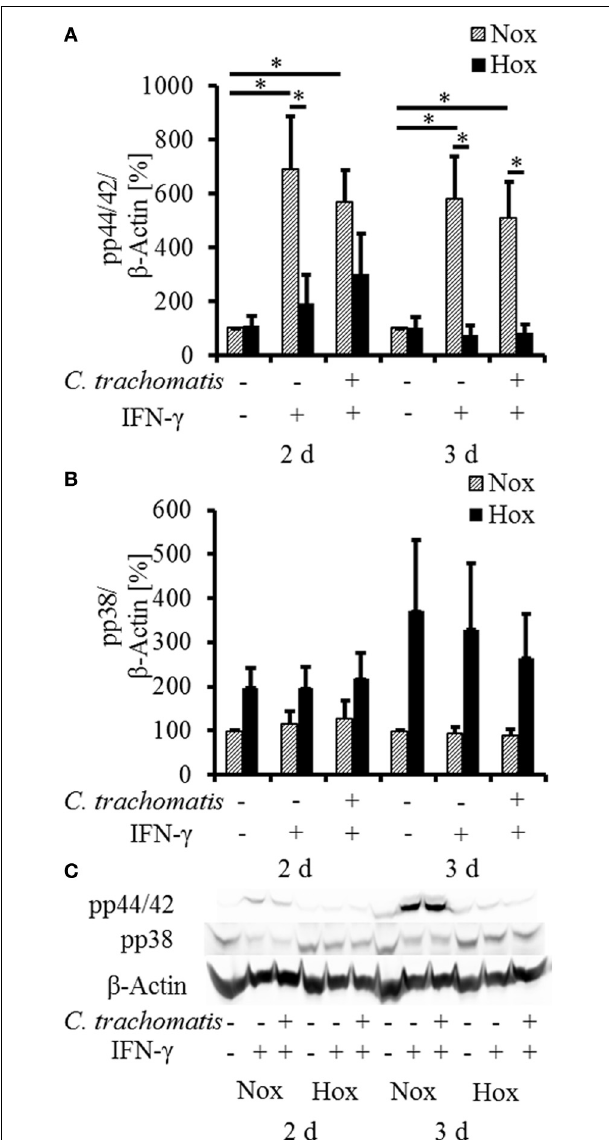
FIGURE 3 | Western blot analysis of MAP-kinase phosphorylation in IFN- γ treated C. trachomatis infected cells under normoxic and hypoxic conditions. Western blot and densitometric analysis of the phosphorylation of the MAP-kinases p44/42 (A) and p38 (B) in IFN- γ treated cells after 2 and 3 d cultivation under normoxic (Nox) and hypoxic (Hox) conditions ( n = 7, mean ± s.e.m., ∗ p ≤ 0 . 05). (C) displays a representative western blot of p38 and p44/42 phosphorylation under normoxic and hypoxic conditions.